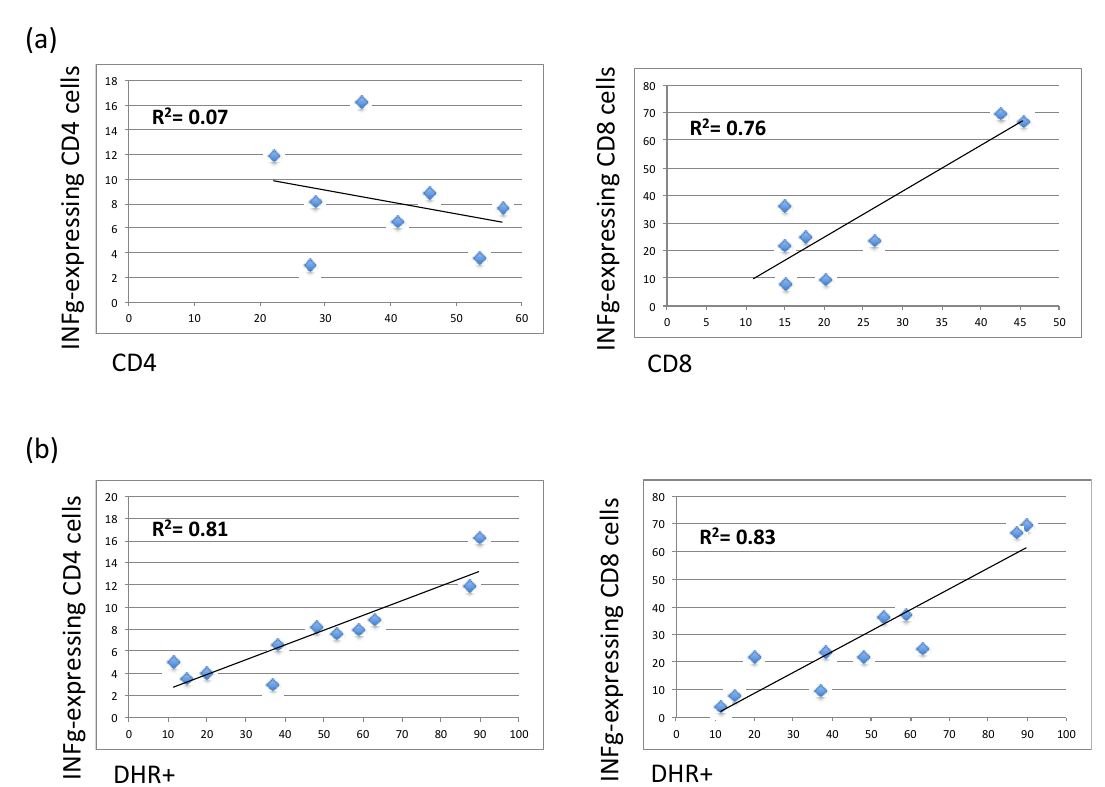
Figure 4. ROS production correlated with the reduced percentage in both CD8 cells and INFg-CD4 expressing cells. Correlation profiles ( Spearman rank correlation test) were calculated: ( a ) % of CD4 cells vs. INF γ -expressing CD4 cells and % of CD8 cells vs. INF γ -expressing CD8 cells; ( b ) % of DHR+ vs. INF γ -expressing CD4 or CD8 cells.